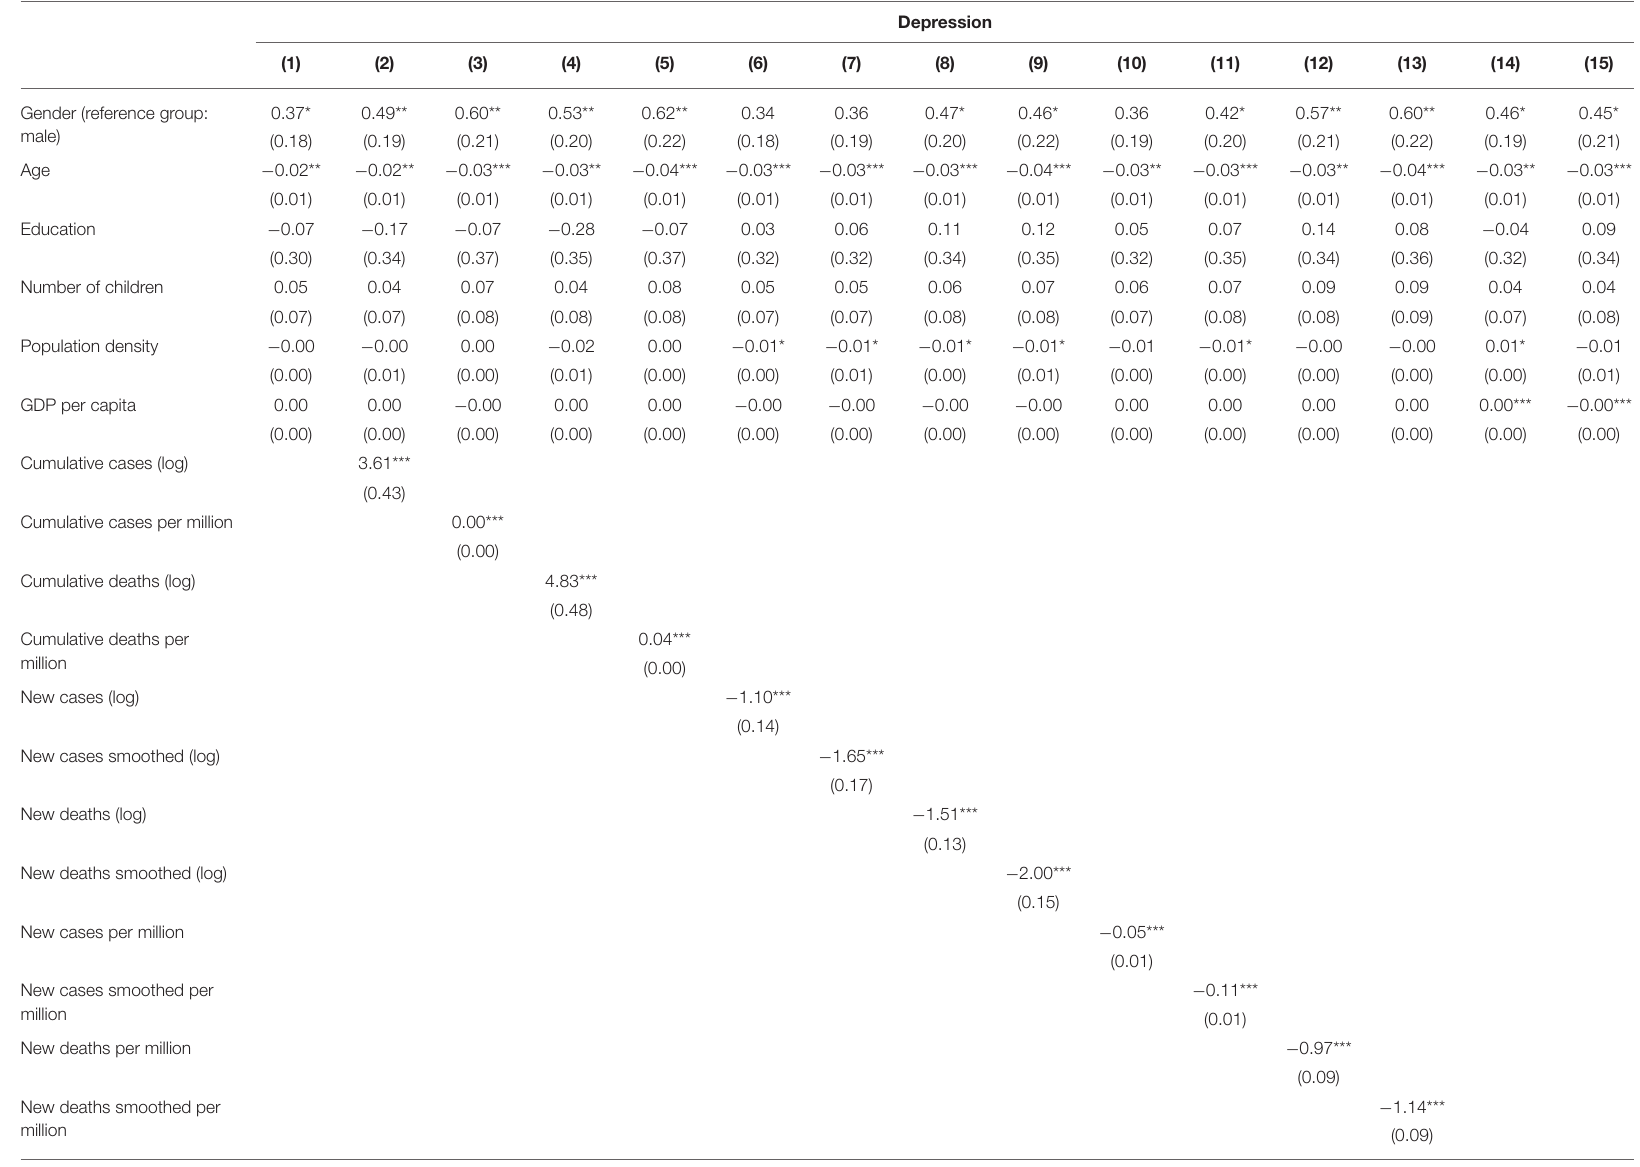
TABLE 4 | Predictors of managers’ depression symptoms in logistic panel regression ( n = 812, N =